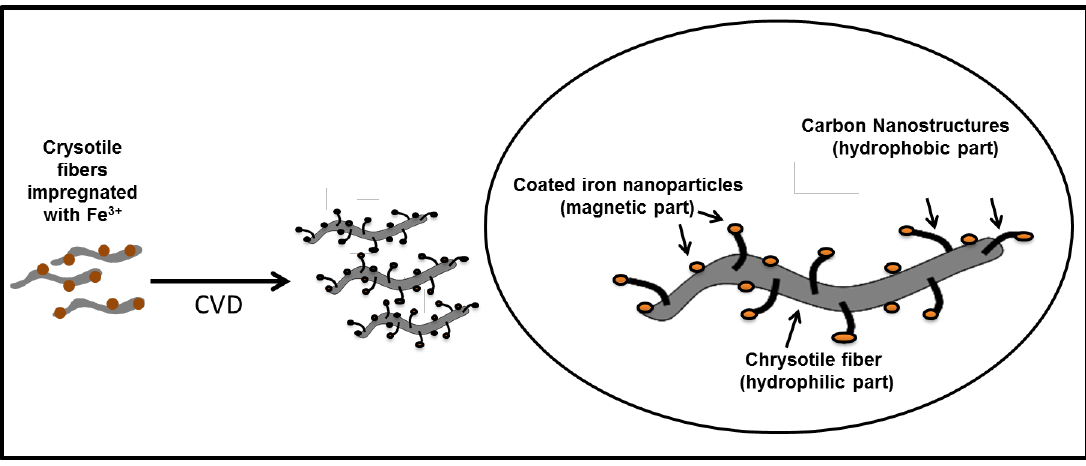
Figure 1. Preparation of magnetic amphiphilic nanoparticles based on Chrysotile obtained by CVD with ethanol.